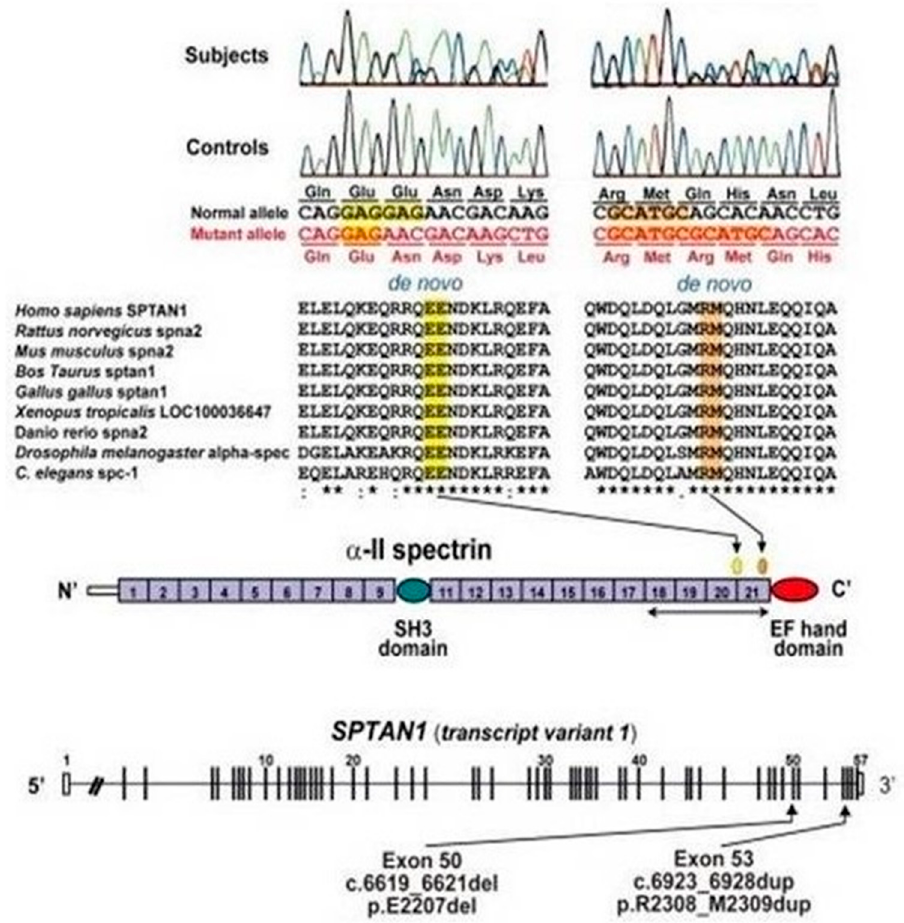
Figure 3. Schematic representation of SPTAN1 gene (transcript variant 1) consisting of 57 exons. Exon 37 of transcript variant 1 is missing in variant 2. Two distinct de-novo mutations were found at evolutionary conserved amino acids in triple helical repeats (spectrin repeats). α -II spectrin consists of 22 domains, including 20 spectrin repeats, and the mutations occurred within the last four spectrin repeats, which are required for α / β heterodimer association.